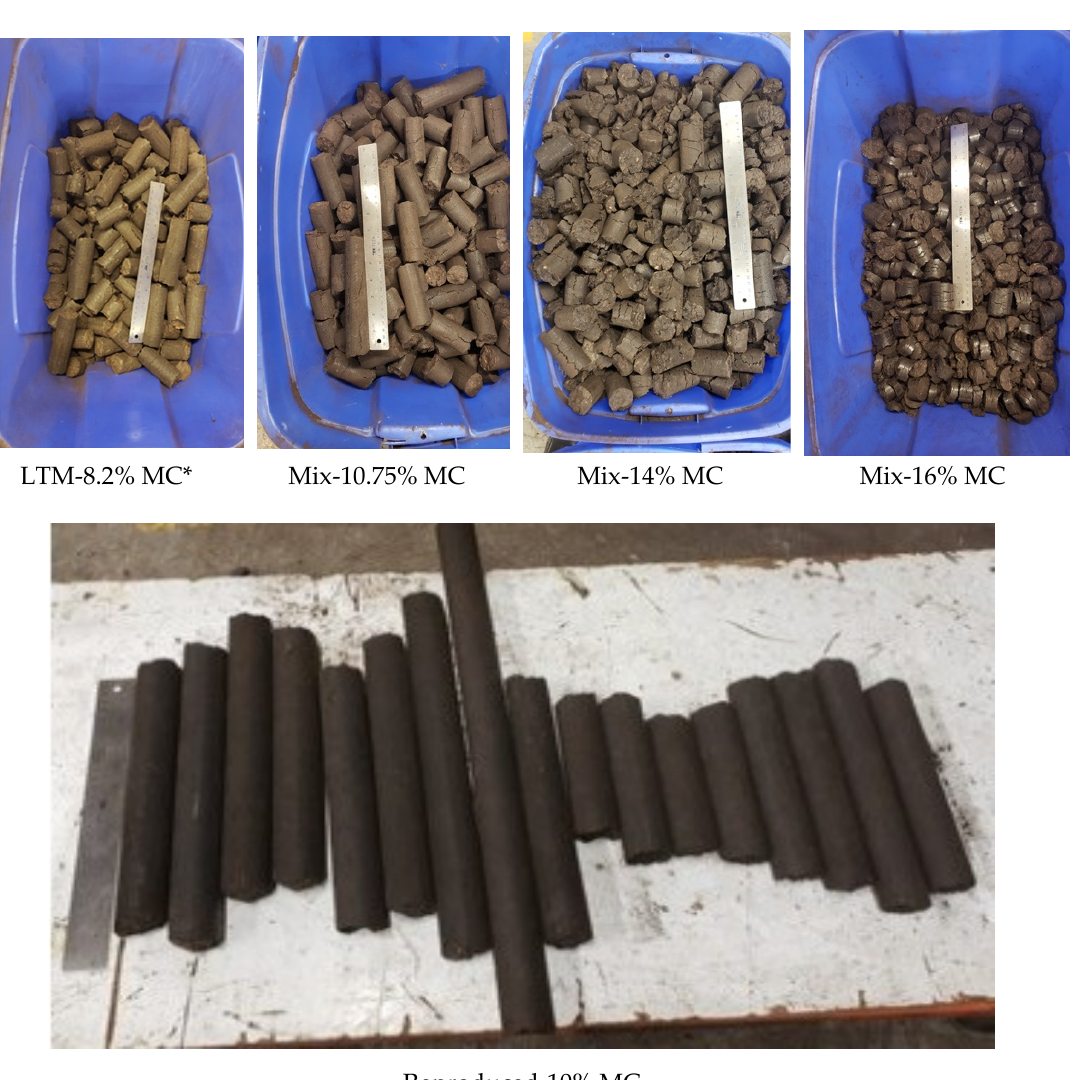
Figure 5. Produced briquettes. *MC: Moisture content (% w.b.).